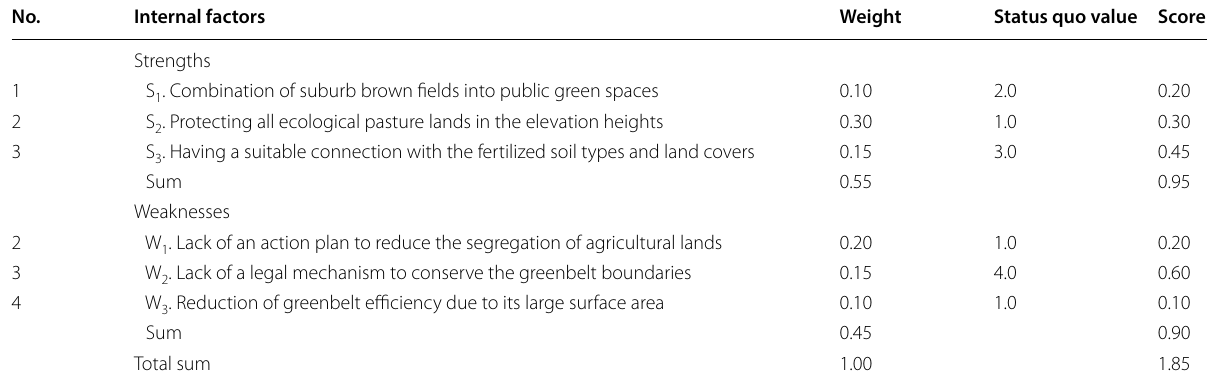
Table 8 Internal factor’s matrix for strengths and weaknesses No.